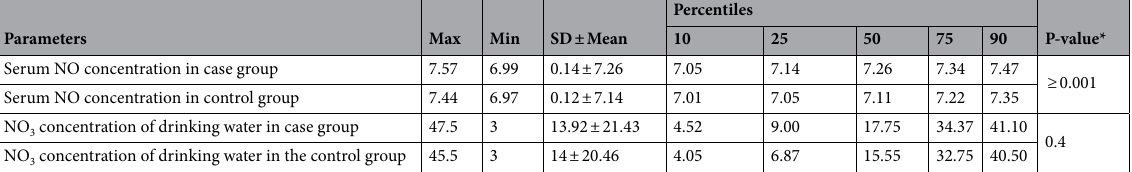
Table 2. Serum NO and drinking water NO 3 distribution levels in the case and control groups. *Man- Whitney U.